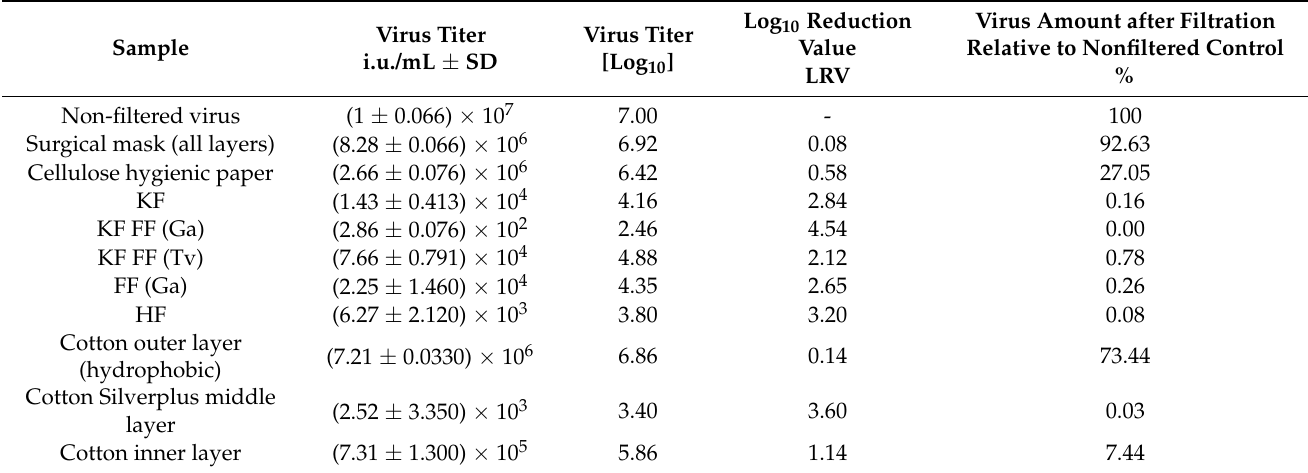
Table 2. SFV1enh/Luc recombinant virus titer change after pressure filtration through experimental materials (KF = Kraft fibers; HF = hemp fibers; FF = fungal fibers; Ga = G. applanatum ; Tv = T. versicolor ).